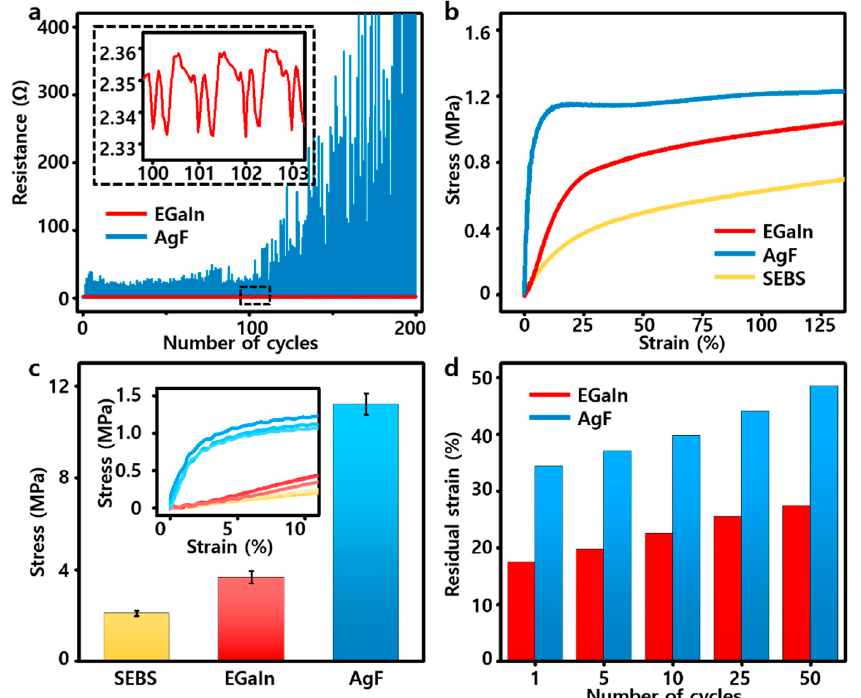
Figure 3. ( a ) Cyclic stretching test of the EGaIn-SEBS and AgF-SEBS composites. ( b ) Stress–strain curves of the SEBS-EGaIn composite, AgF-SEBS composite, and bare SEBS film sample. ( c ) Compar- ison of the modulus of the samples. Data are expressed as the mean ± s.d. (n = 3) ( d ) Number of cycles dependent on residual strain of the EGaIn-SEBS and AgF-SEBS composites.